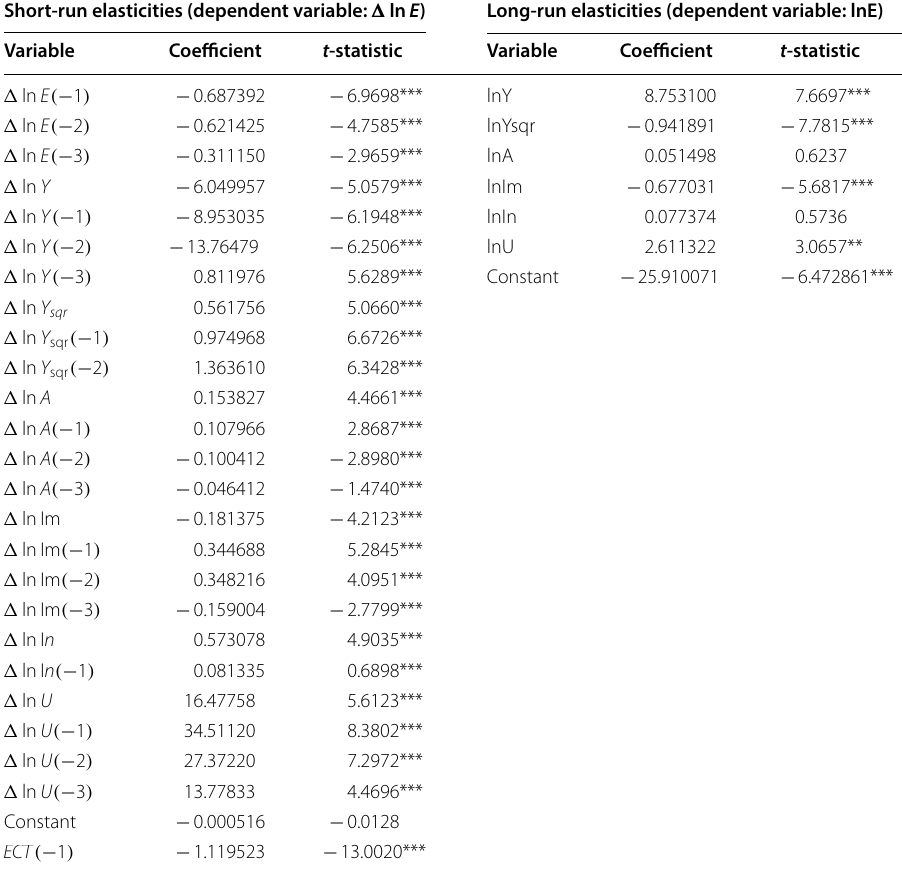
Table 3 Estimated coefficients from ARDL model Source: Own computations (2018) Short-run elasticities (dependent variable: (cid:31) ln E